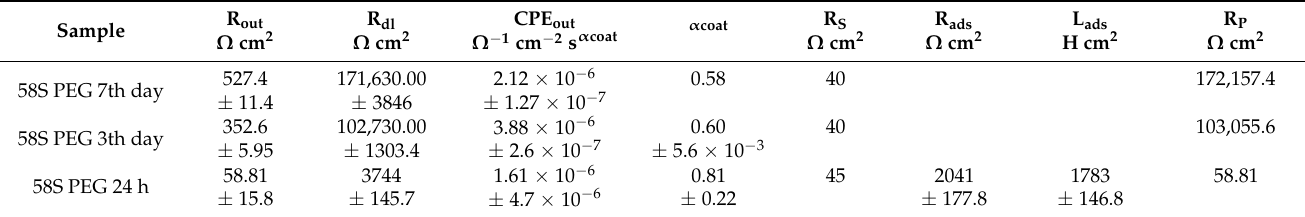
Table 2. Fitted values of the equivalent circuit for 58S_PEG samples as a function of immersion time in Hank’s